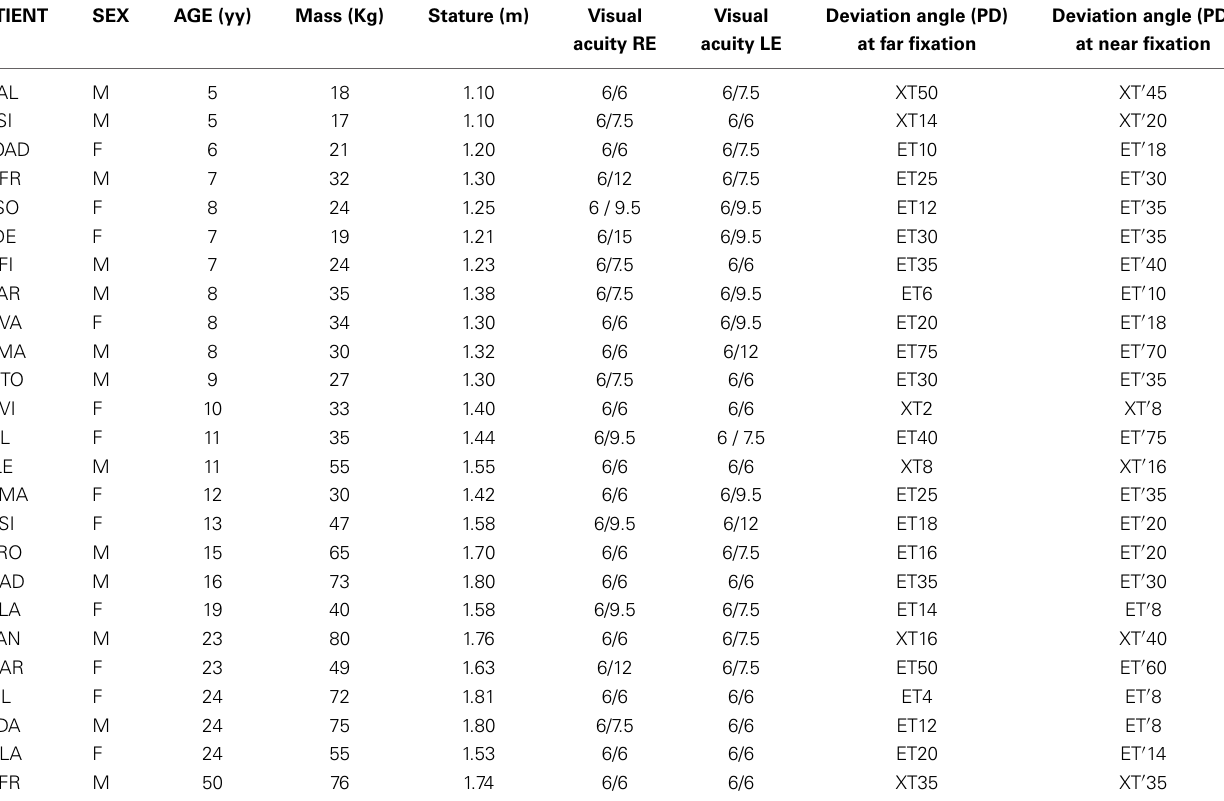
Table 1 | Anthropometric and ophthalmological/orthoptic evaluation of patients with strabismus. PATIENT Mass (Kg) Stature (m) Visual Visual Deviation angle (PD) Deviation angle (PD) acuity RE acuity LE at far fixation at near